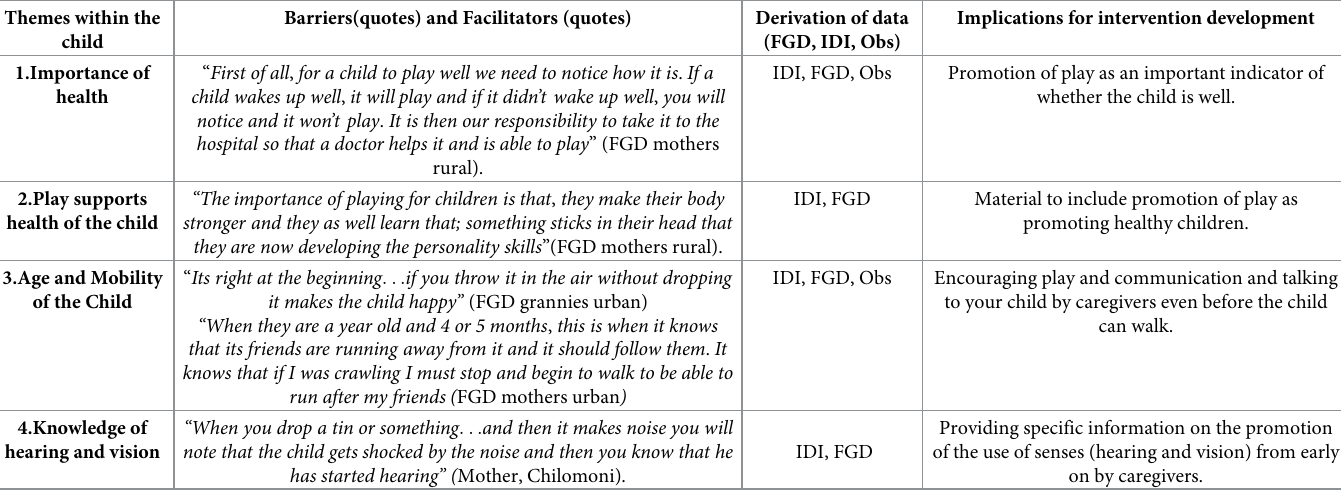
Table 3. Barriers and facilitators at the level of the child of 0–2 years that affect integration of the care for child development package in Malawi. Themes within the Barriers(quotes) and Facilitators (quotes) Derivation of data child